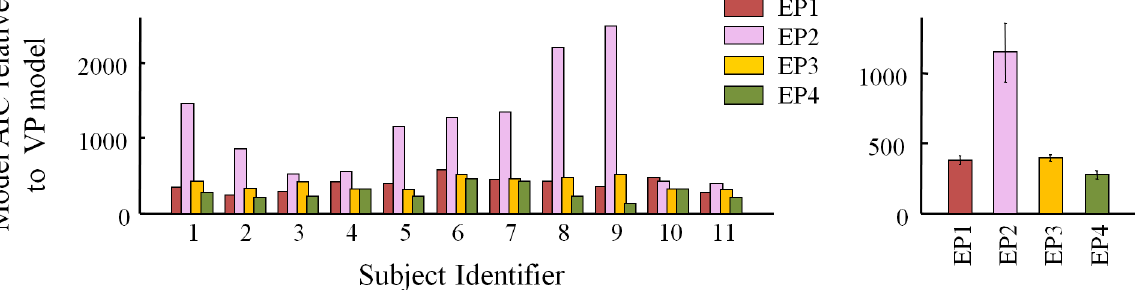
Fig 5. AIC model comparison for equal versus variable precision. Shown are AIC differences of EP models relative to VP models for each subject (left) and averaged over subjects (right). Higher AIC mean worse fits. BIC results are consistent (S1a Fig).